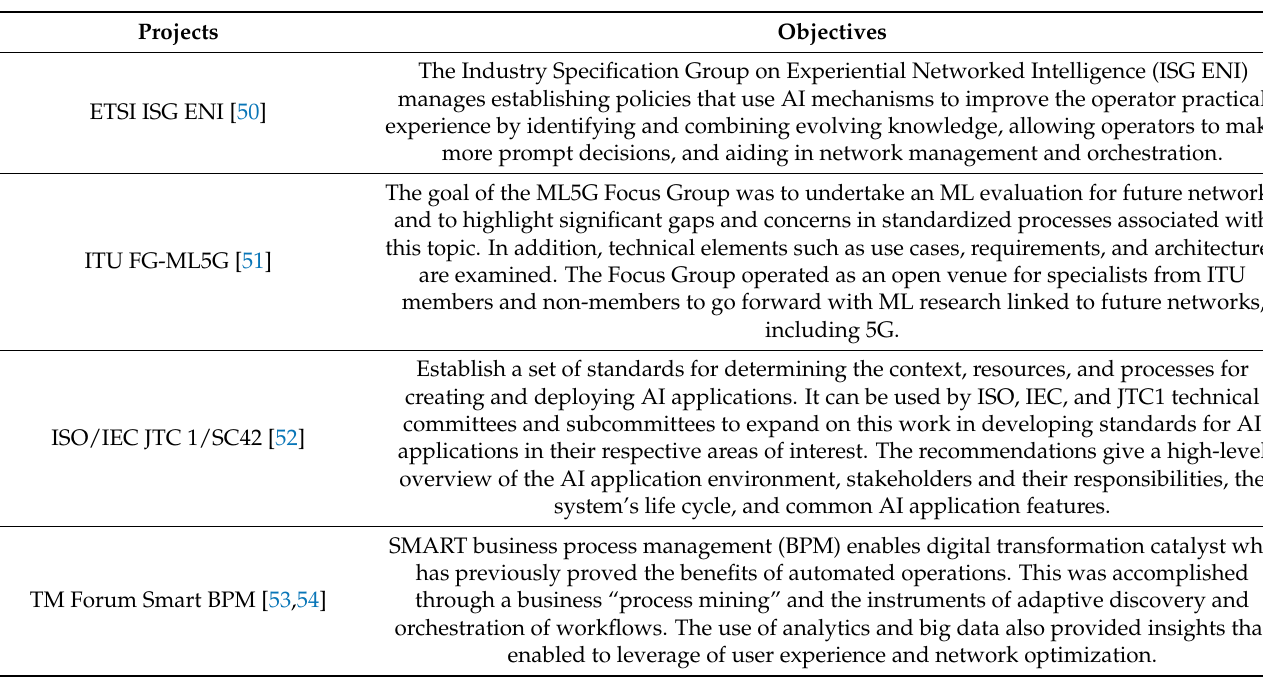
Table 6. The perspective of SDOs and industrial forums on using AI and